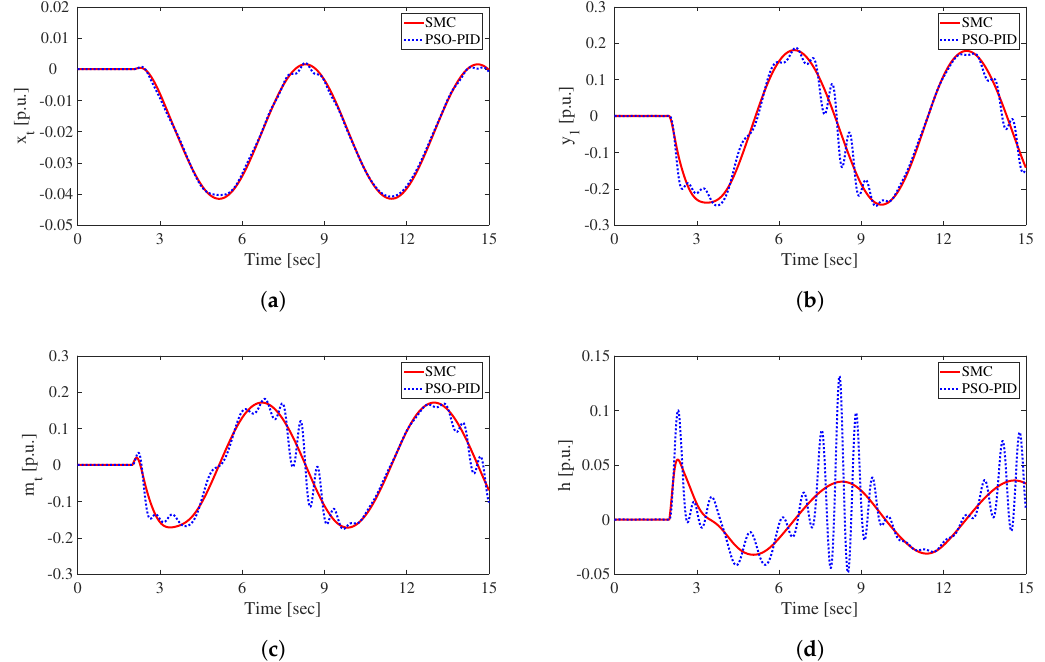
Figure 7. The time waveforms of ( a ) x t ; ( b ) y 1 ; ( c ) m t ; and ( d ) h under periodic speed